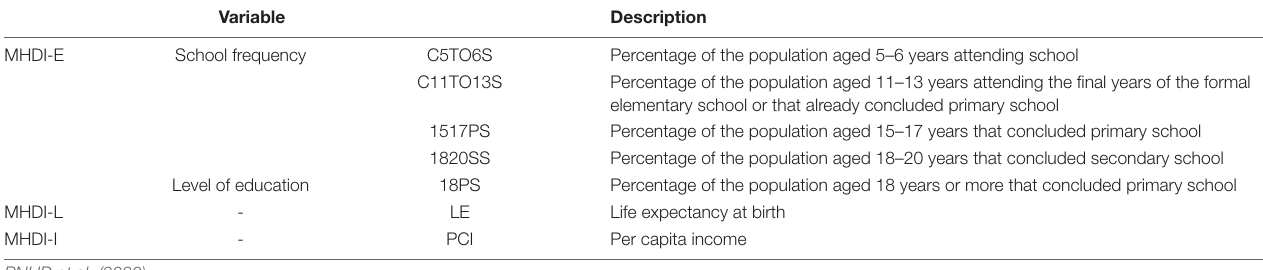
TABLE 1 | The indicators and dimensions of MHDI.